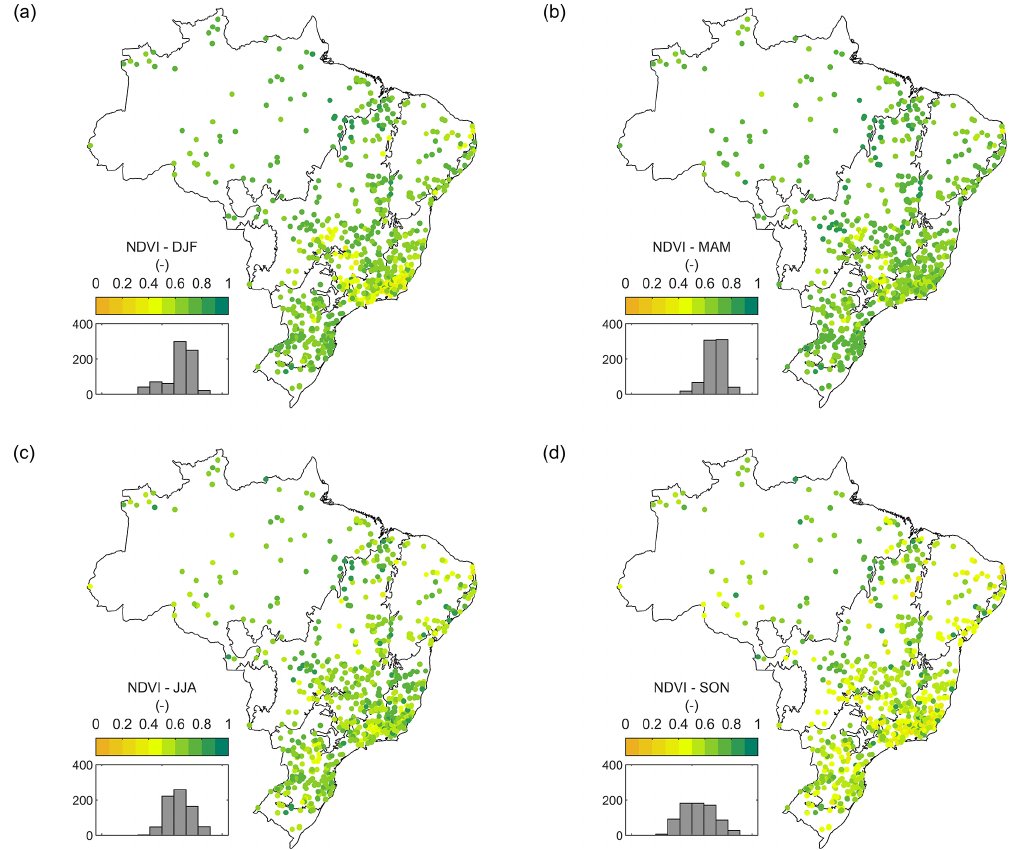
Figure 12. Spatial distribution of the seasonal NDVI of the CABra catchments. (a) NDVI in the summer season (DJF); (b) NDVI in the autumn season (MAM); (c) NDVI in the winter season (JJA); (d) NDVI in the spring season